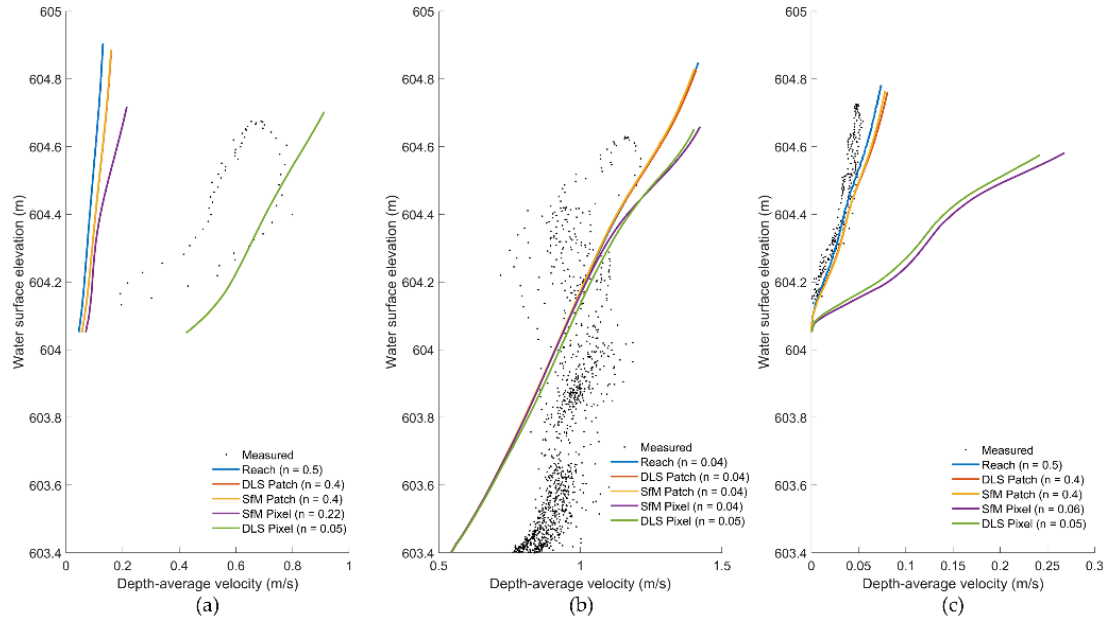
Figure 6. Velocity sensor data compared to modeled velocities and WSE with roughness values of each velocity sensor location denoted: ( a ) data taken from upstream floodplain at an elevation of 603.412 m, ( b ) Data taken from channel bed at an elevation of 602.949 m, ( c ) Data taken from downstream floodplain at an elevation of 603.825 m.